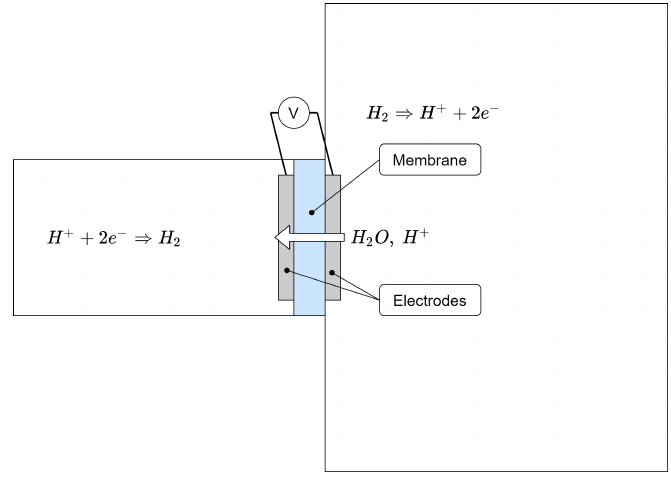
Figure 10. Principle of hydrogen pump cell (based on the work in